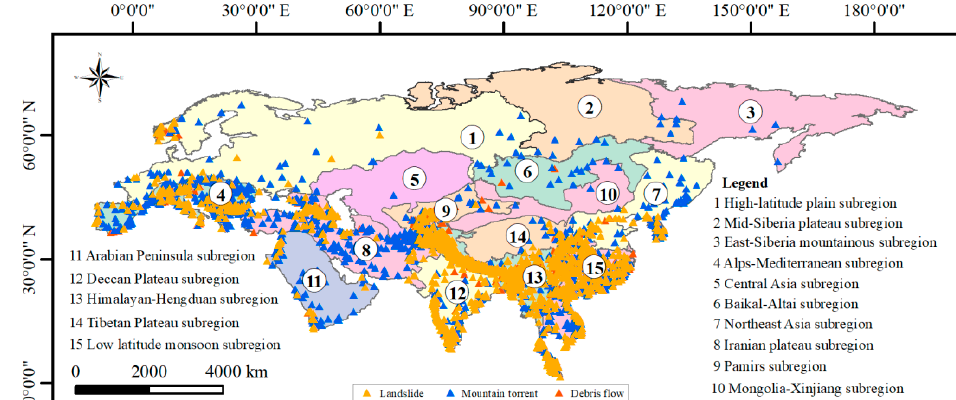
Figure 12. Mountain-hazards distribution in different subregions.